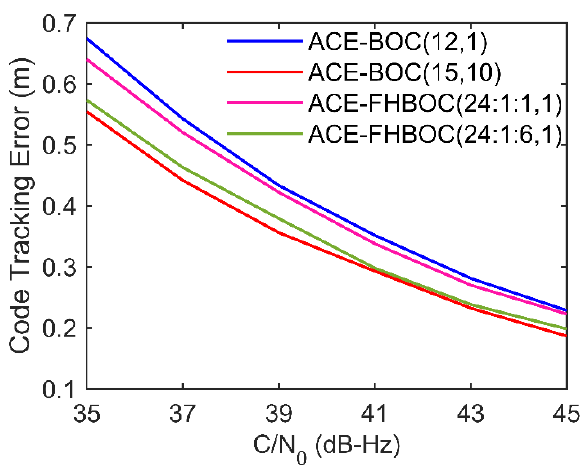
Figure 14. NELP code tracking errors for the example signals.